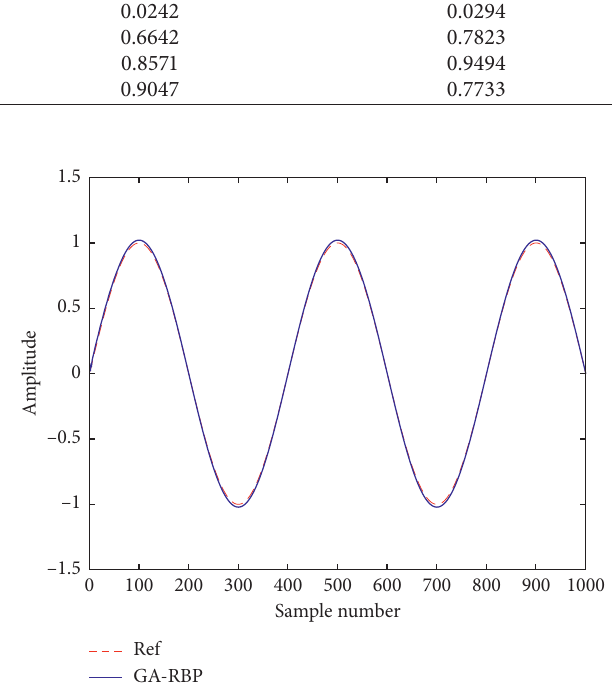
Figure 5: Tracking performance of the proposed algorithm on System